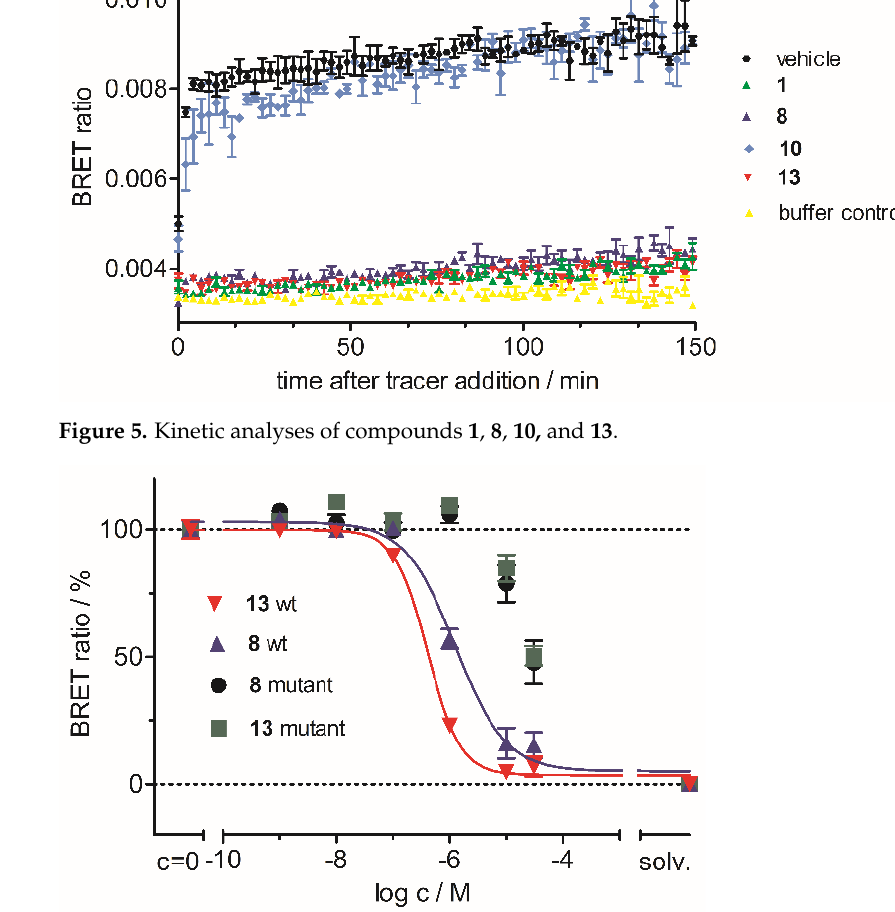
Figure 5. Kinetic analyses of compounds 1 , 8 , 10, and 13 .